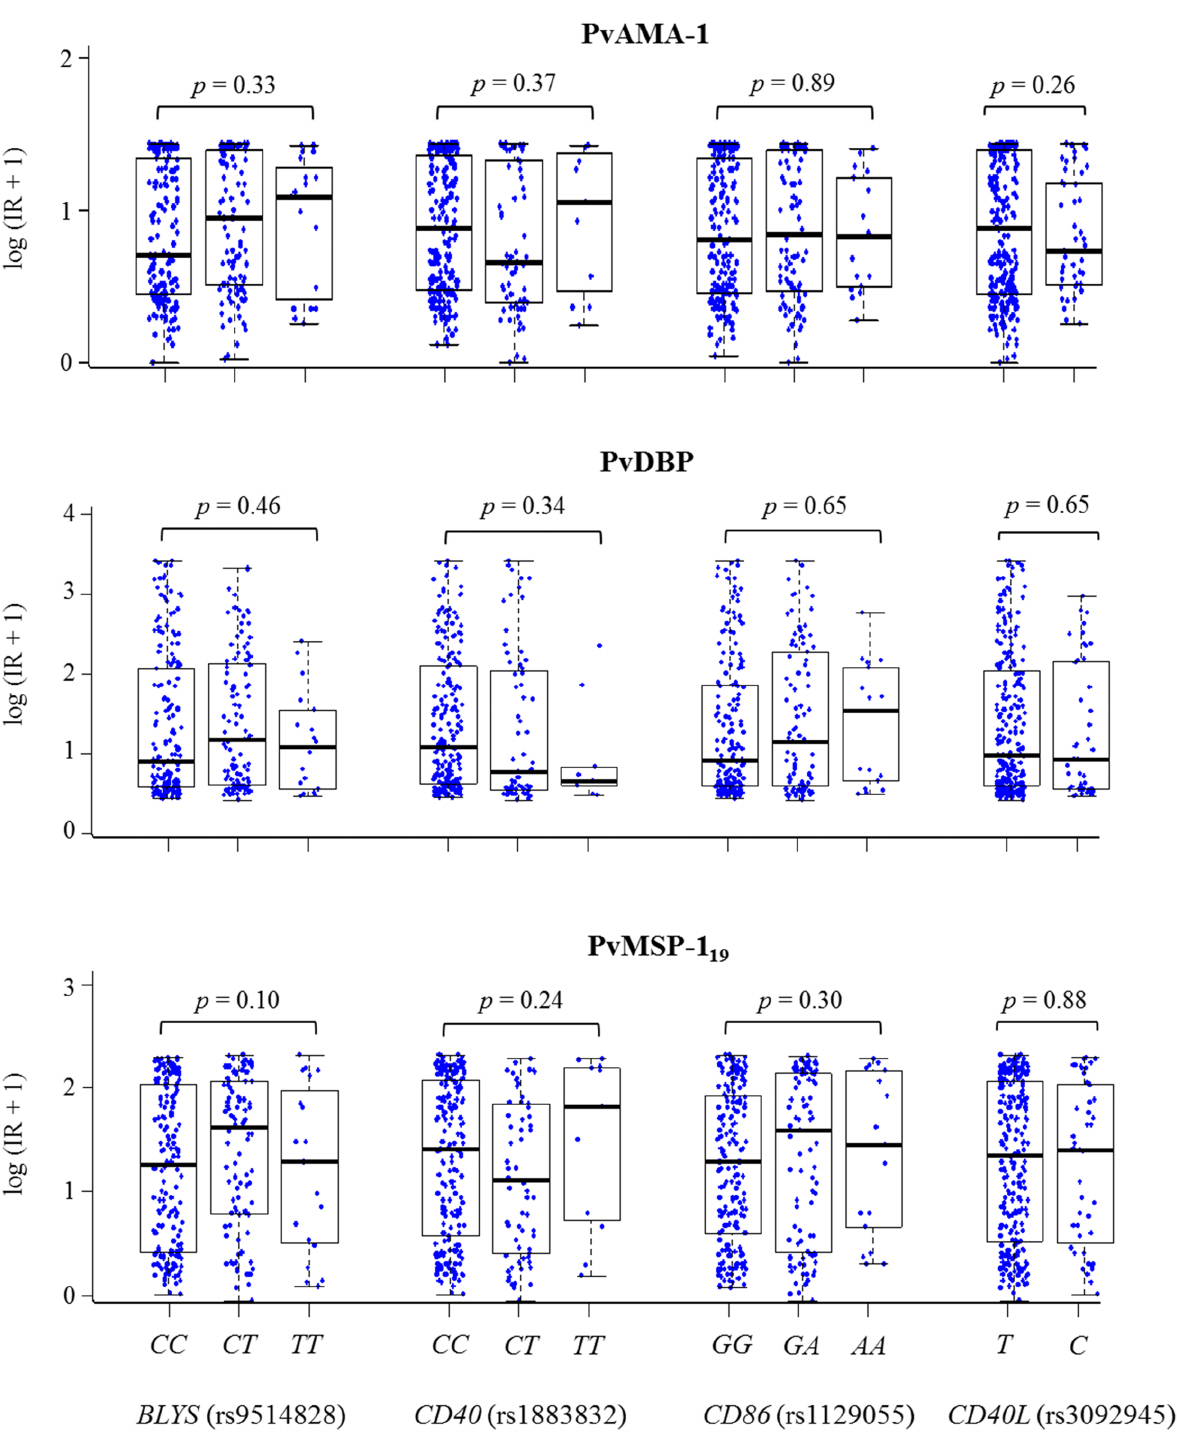
Fig 2. BLYS , CD40 , CD86 , and CD40L genotypes in relation to antibody titers against the merozoite proteins. Antibody titers were expressed as log- transformed reactivity indices (RI). For the SNP in the gene CD40L , men and women harboring the C allele were grouped and compared with individuals who did not possess this allele given that CD40L is located on chromosome X. Multivariate logistic regression analysis found no significant differences in the antibody titers between the different genotypes.